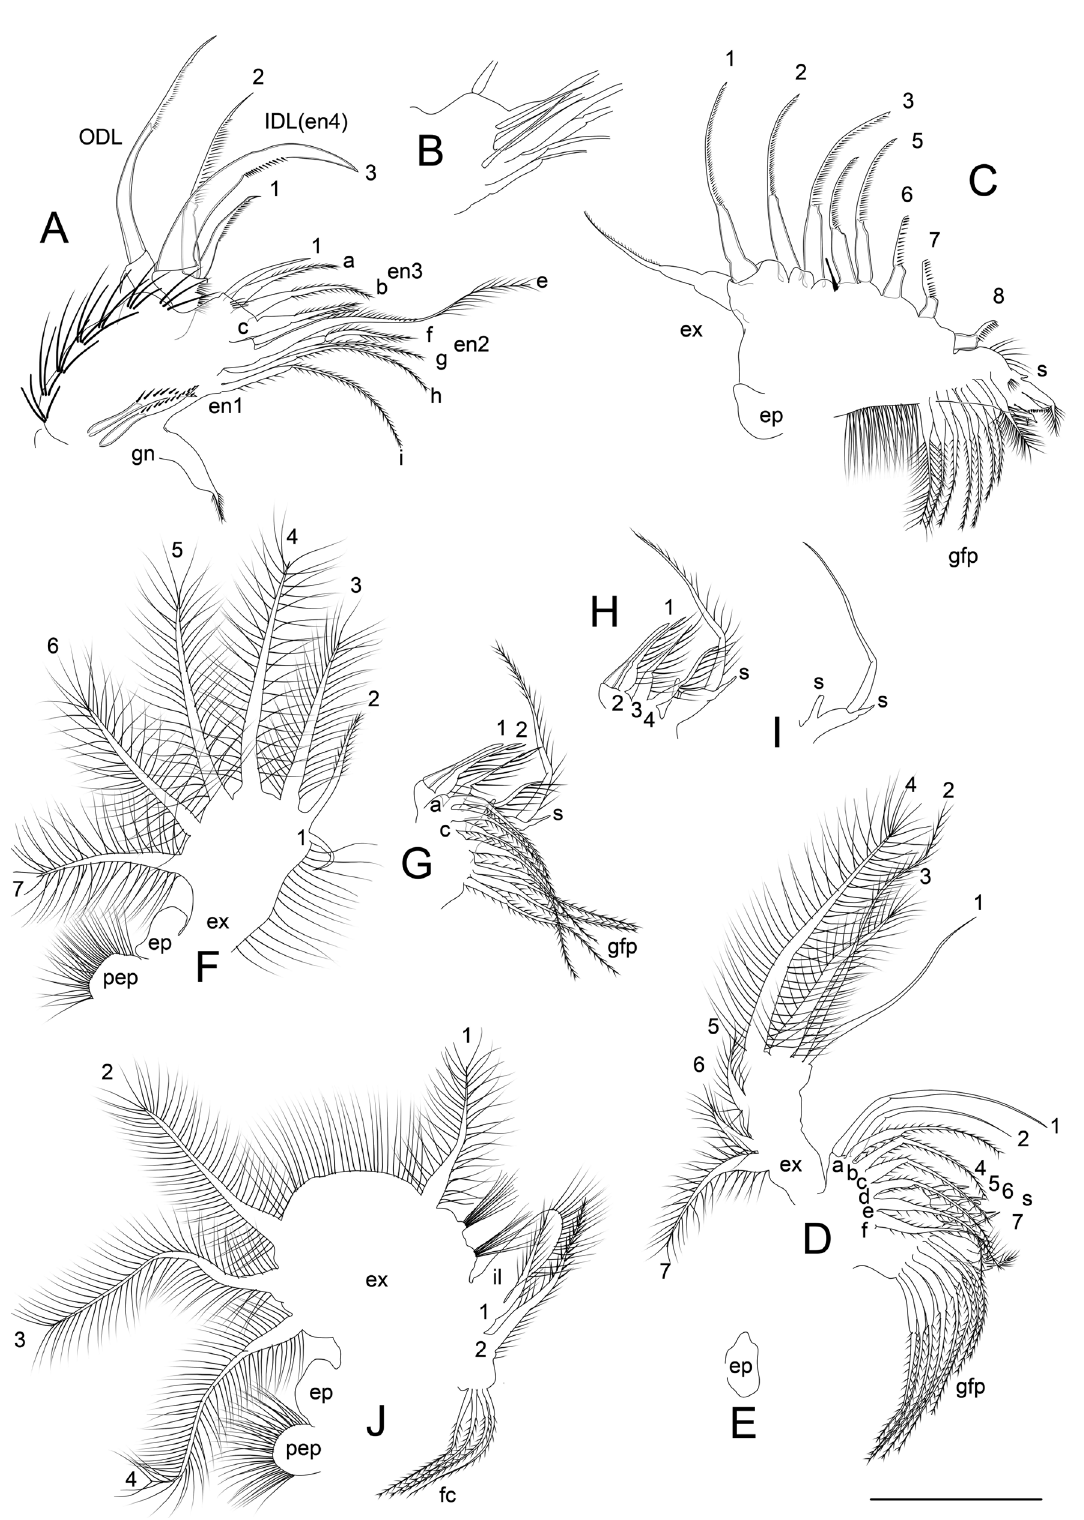
Fig. 8. Disparalona ( Mixopleuroxus ) lucianae sp. nov., parthenogenetic female. A . First limb. B . Idem , stiff setae. C . Second limb. D . Third limb. E . Idem , epipodite. F–G . Fourth limb. H . Idem , distal endite. I . Elements. J . Fifth limb. Scale bar = 50